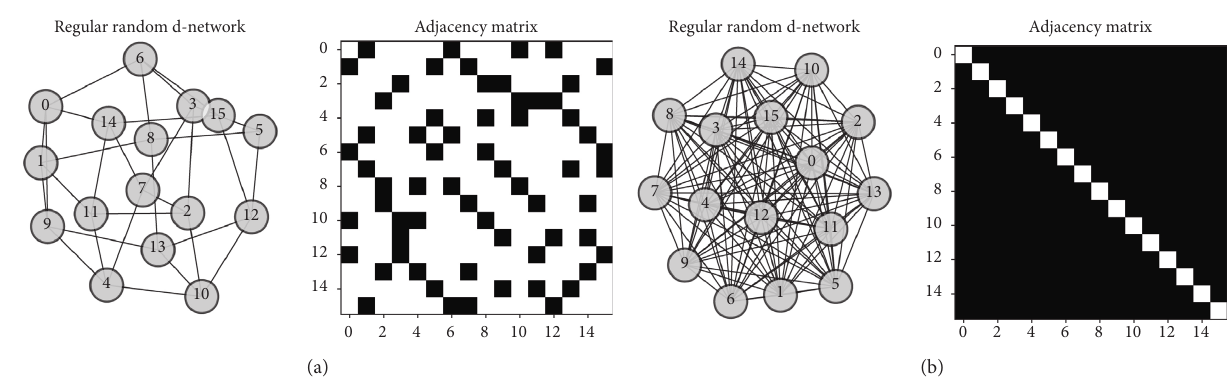
Figure 4: Prototype of a random regular network with its properties. The number of nodes n � 4 ∗ 4; connection degree (probability) d � 15 (b) and d � 4 (a). For each section, the plots of the left-hand side show the random (regular) network that was created. The circles represent nodes with an arbitrarily assigned label from 0 to 15, and each line represents a link. The plot on the right-hand side of each section shows the adjacency matrix with entries in row m and column n (either 1 (black) or 0